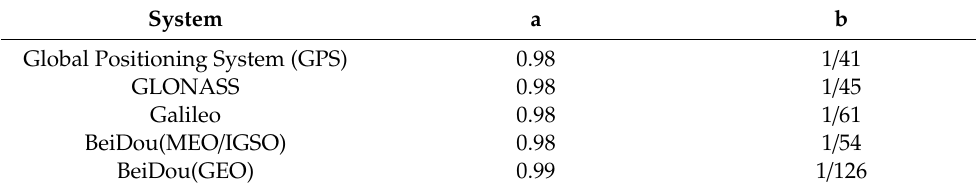
Table 4. Coe ffi cient of Signal-in-Space Ranging Error (SISRE).